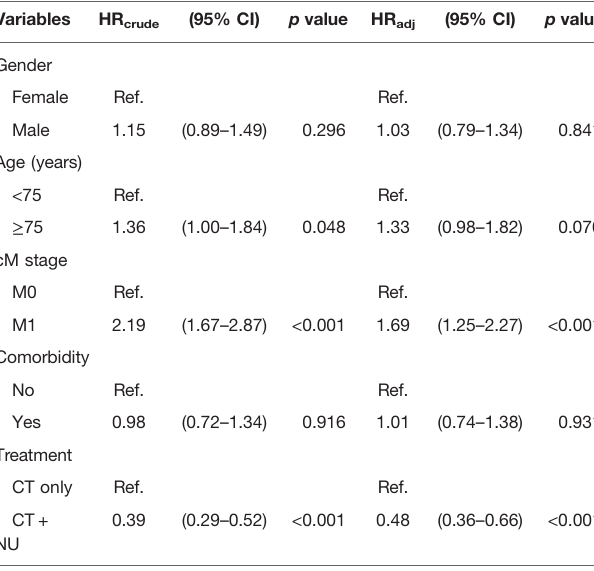
TABLE 2 | Multivariate Cox regression analysis of 3-year overall survival for patients with stage IV upper urinary tract urothelial cancer.